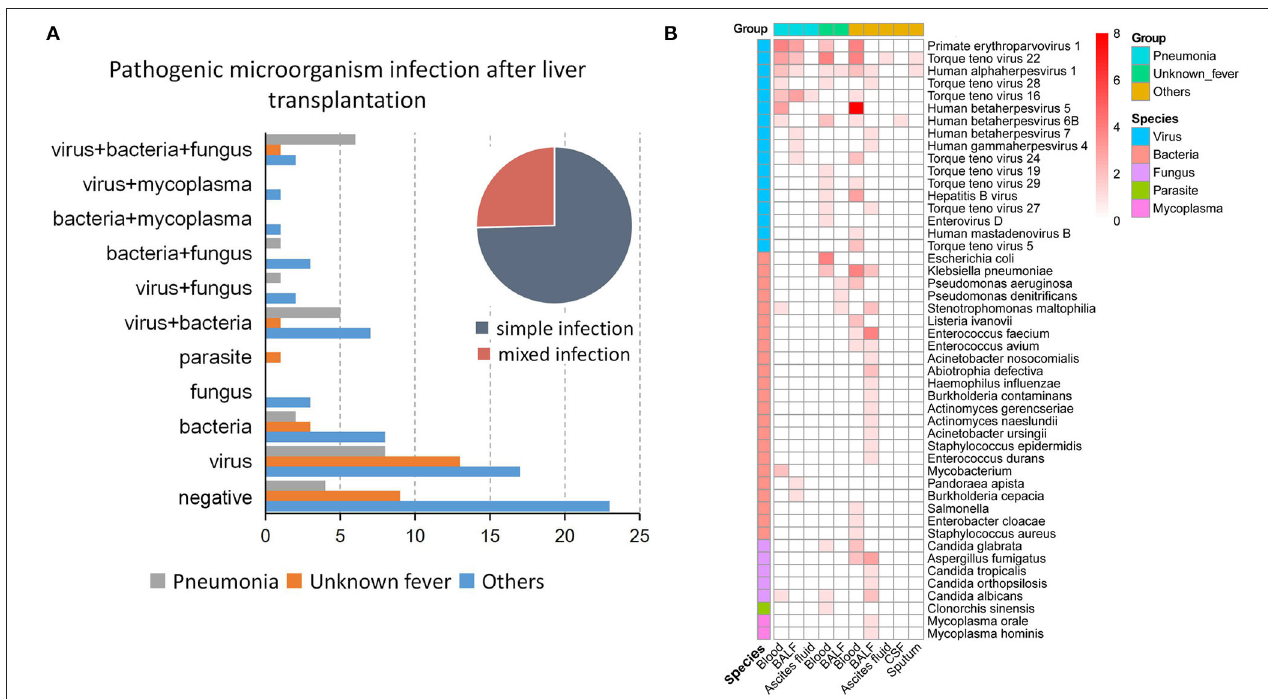
FIGURE 3 | Types of infections and pathogen species after liver transplantation. (A) The type of infection in the three groups, including the proportion of simple and mixed infections. (B) The proportion of 48 pathogenic microorganisms in each sample type in the three groups.